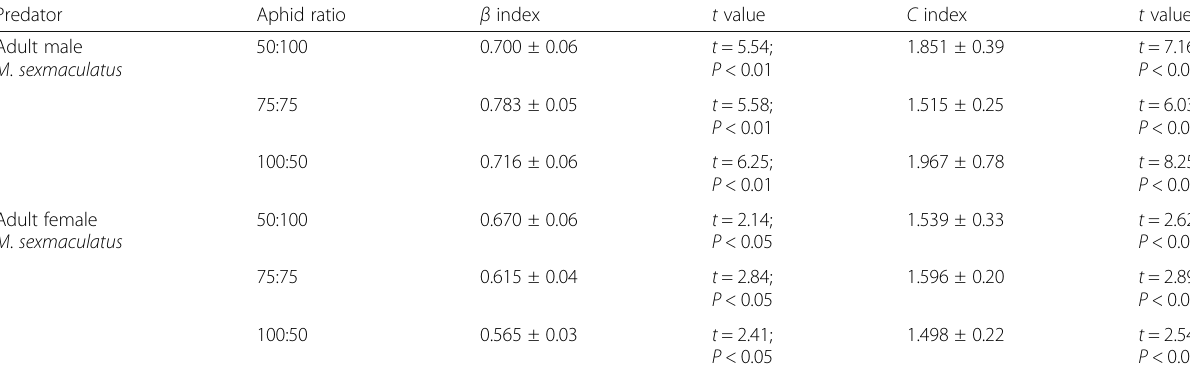
Table 2 Preference indices ( β and C ) evaluated from different aphid proportions ( Acraccivora : L . erysimi) exposed to M . sexmaculatus in cafeteria experiment